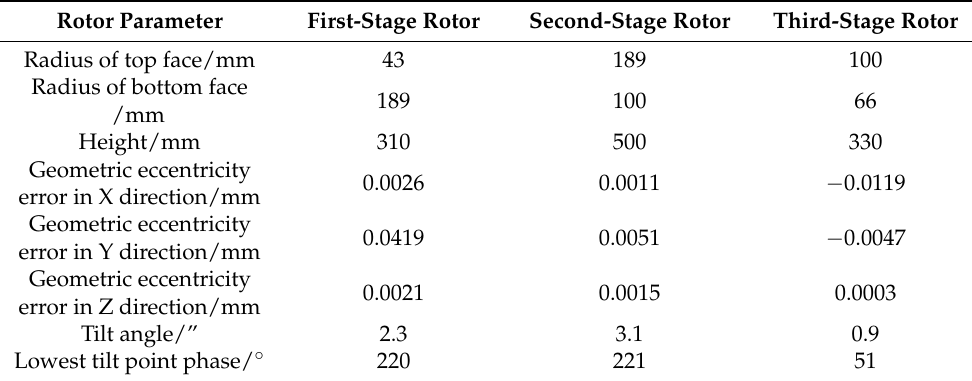
Figure 6. Test device diagram of rotor geometric parameters and mass parameters: ( a ) Precision air bearing turntable; ( b ) Experimental rotor. Table 2. Rotor geometric characteristics and parameter errors of rotary parts rotors.